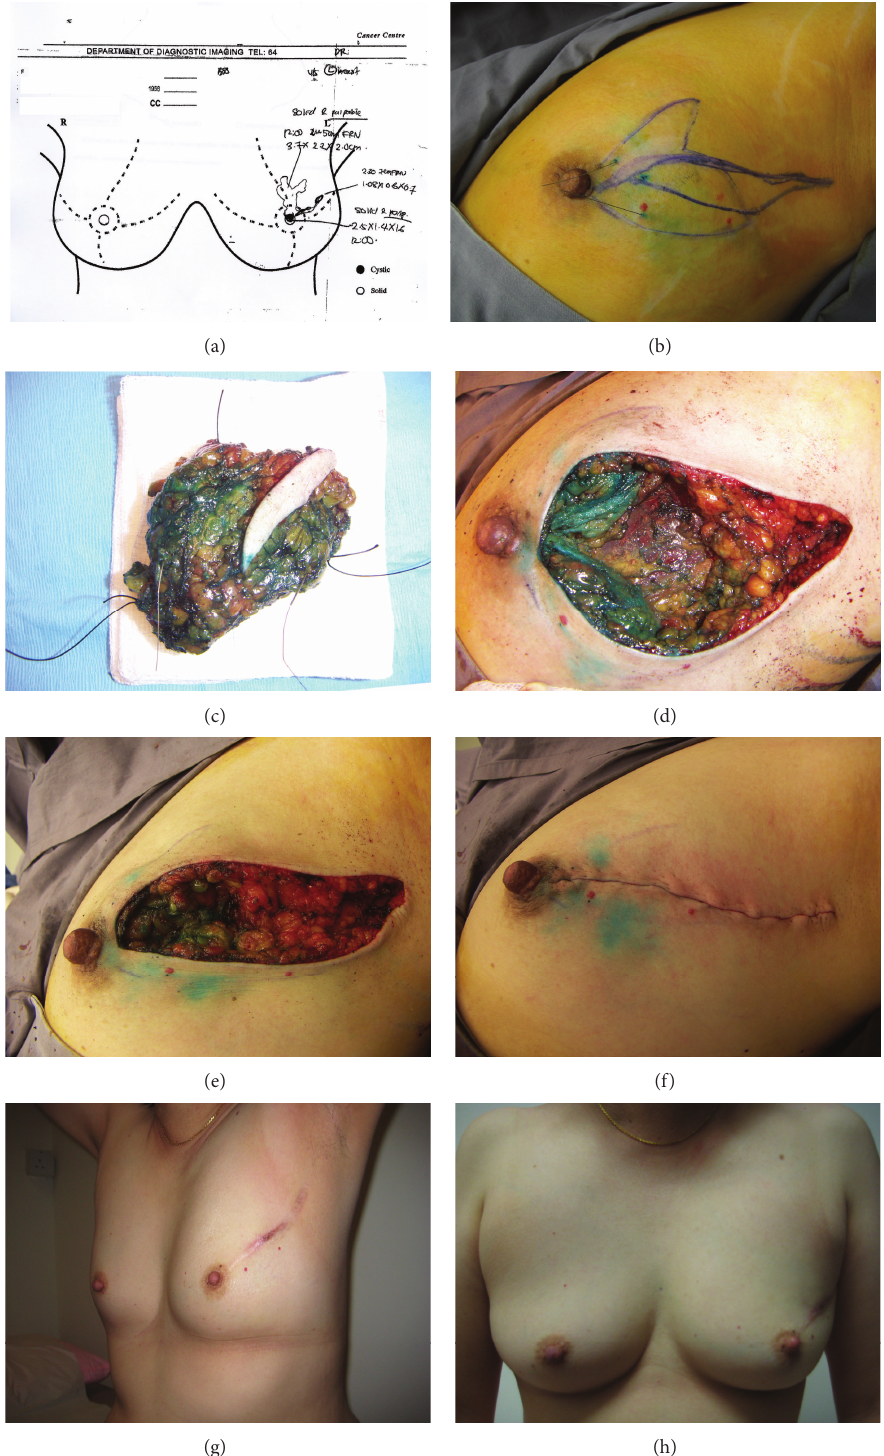
Figure 2: ((a)–(h)) Avoiding mastectomy in a patient with “multicentric tumour” on imaging. This patient was diagnosed to have high grade ductal carcinoma in situ (DCIS) at an oncology centre and was offered mastectomy on the assumption that this was a multicentric lesion. She sought a second opinion with the authors and was agreeable to a “trial of breast conservation treatment.” Just prior to surgery, the lateral and medialextentsofherdual-segmentdiseasewerelocalisedunderultrasoundguidance.Tissueresectionwasplannedasindicatedtobalancethe need for negative margins and retention of sufficient uninvolved parenchyma for defect repair. Through a radial incision and eccentric ellipse, an en bloc resection of the lesion using a multisegment resection pattern was performed. Sentinel node biopsy was performed through the same incision for this palpable high grade DCIS. Histology was reported as a unifocal 25 mm high grade DCIS. No multicentric component could be identified. She completed all adjuvant treatment and is now disease-free more than 5 years after